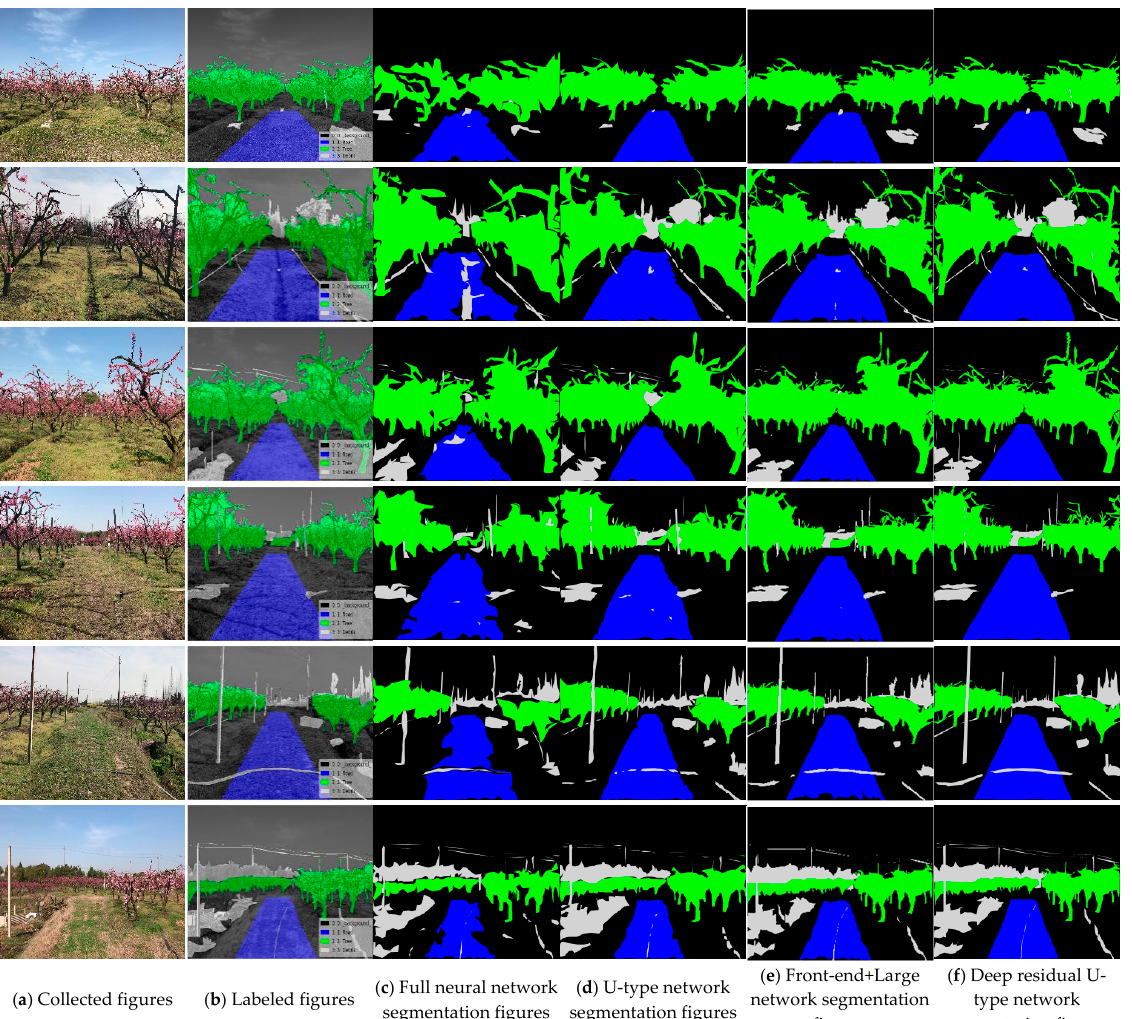
Figure 9. Semantic segmentation prediction images from different network models.